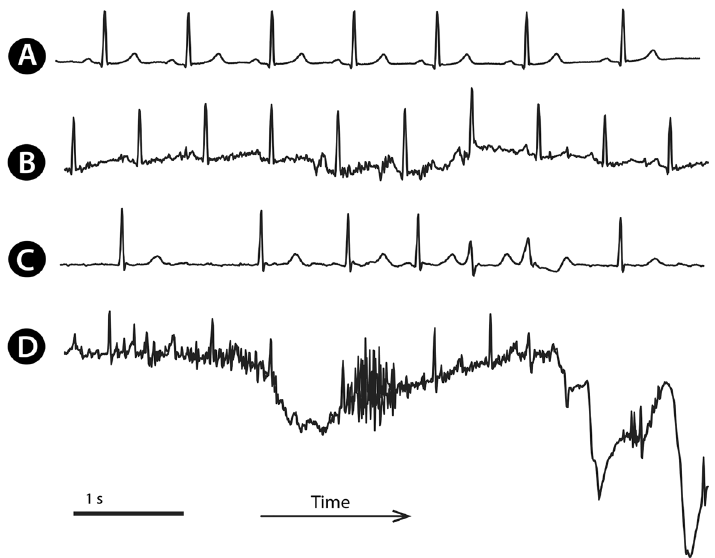
Figure 1. Examples of Holter ECG signals: Normal sinus rhythm ( A ); the same patient with the same rhythm, but disturbed by noise due to patient movements ( B ). A different patient with atrial fibrillation and premature ventricular contractions (PVC) in a couplet ( C ); the same patient a few minutes later, with disturbed ECG signal ( D ) with at least one PVC.